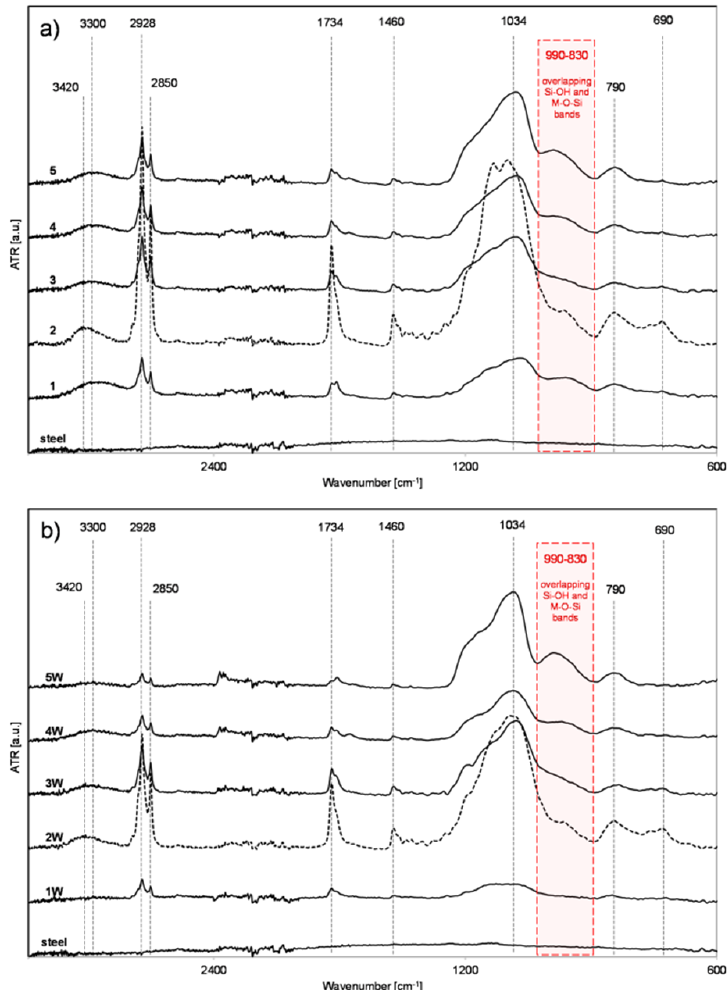
Figure 4. ( a ) FT-IR spectra of coated steel samples and ( b ) corresponding samples after conditioning in water.